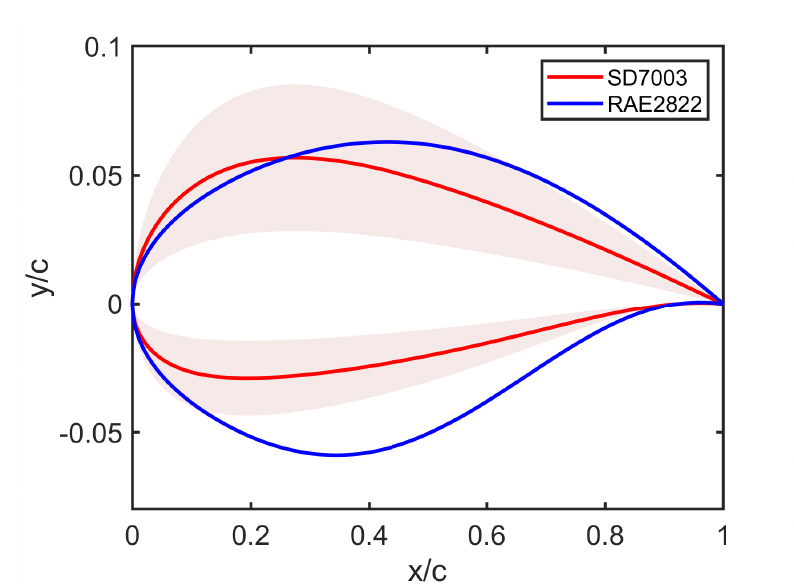
Figure 2. Demonstration of baseline airfoil, design space and target